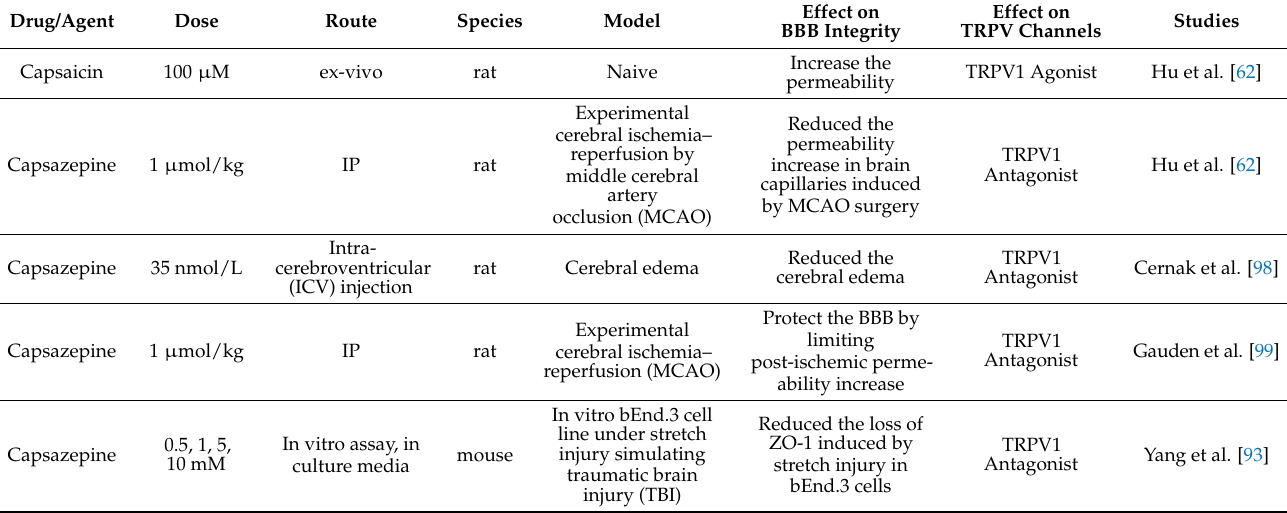
Table 4. Drugs/Agents targeting TRPV channels in modulating BBB